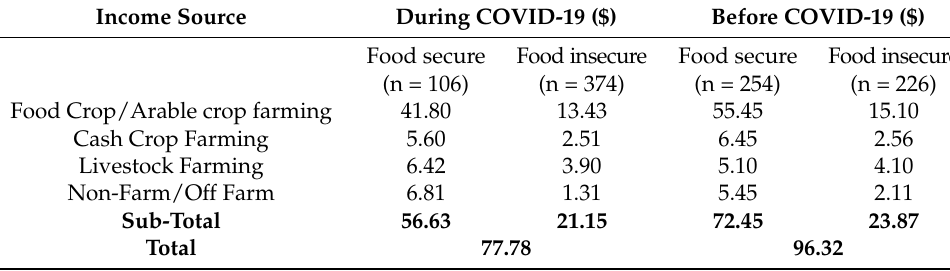
Table 5. Food security status by household annual income ($) and income